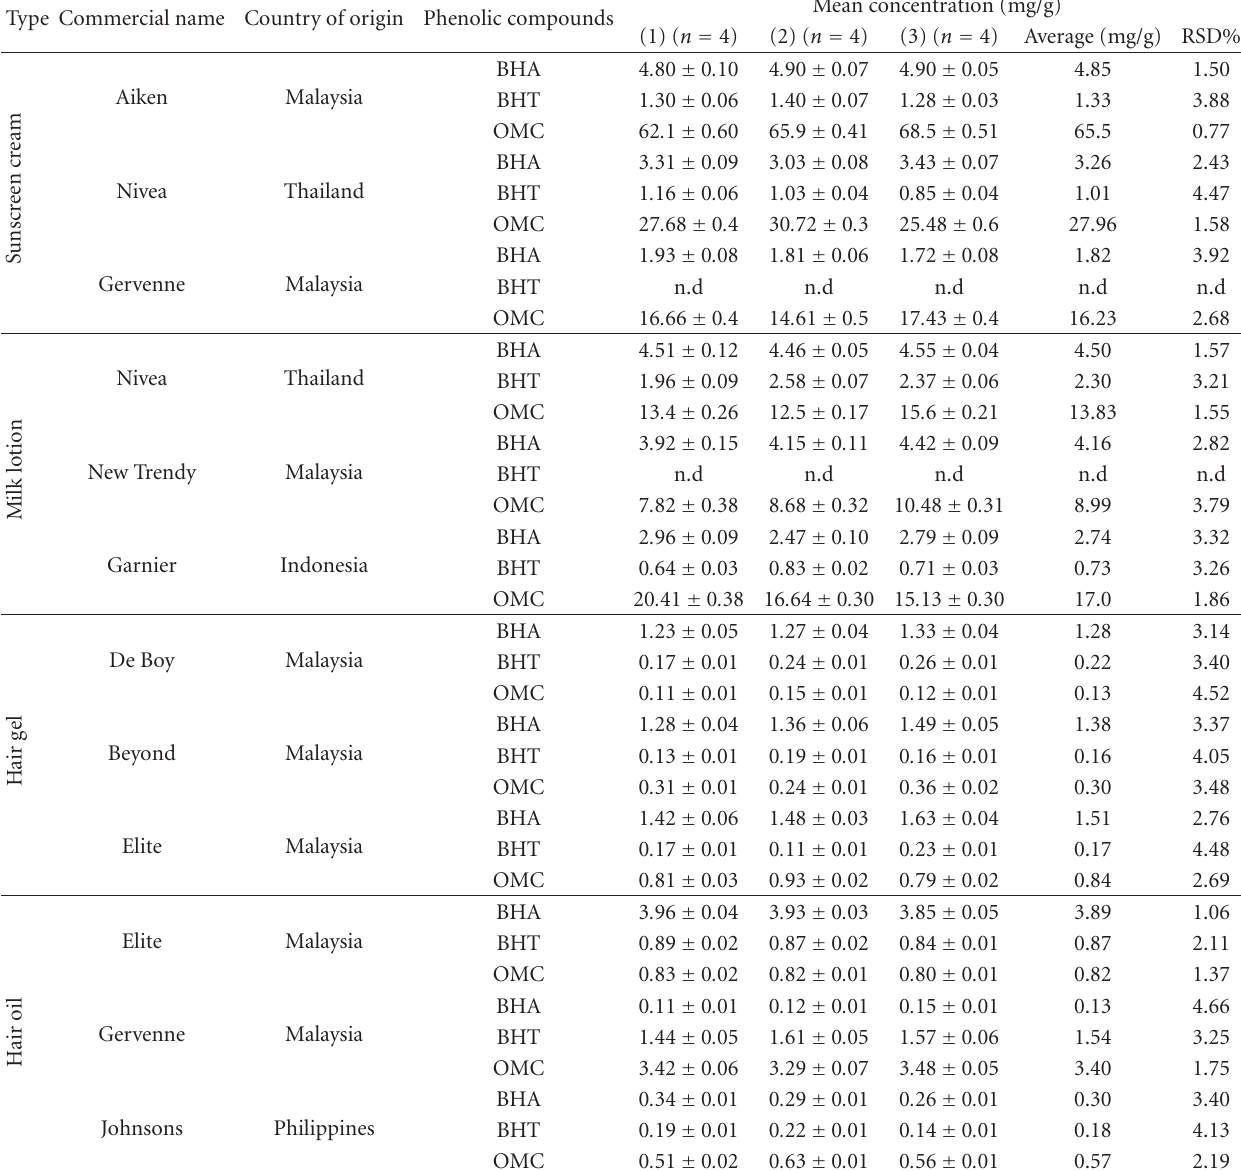
Table 5: Concentration of BHA, BHT, and OMC in sunscreen cream, milk lotion, hair gel, and hair oil samples determined by RP-HPLC- UV/Vis at λ max = 280